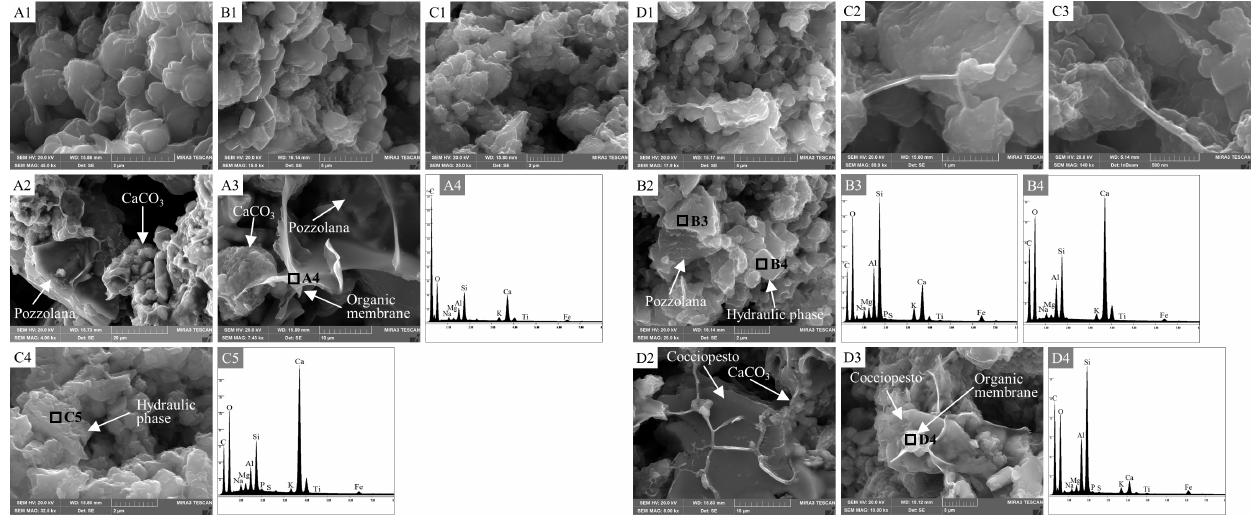
Figure 3. SEM images of CaCO 3 particles (A1–C3), hydraulic phases and their respecting EDS spectra (A2–D4) in specimen A (quicklime + oxblood + pozzolana + iron powder, B (quicklime + water + pozzolana + iron powder), C (hydrated lime + oxblood + pozzolana + iron powder), D (quicklime + oxblood + opussigninum + iron